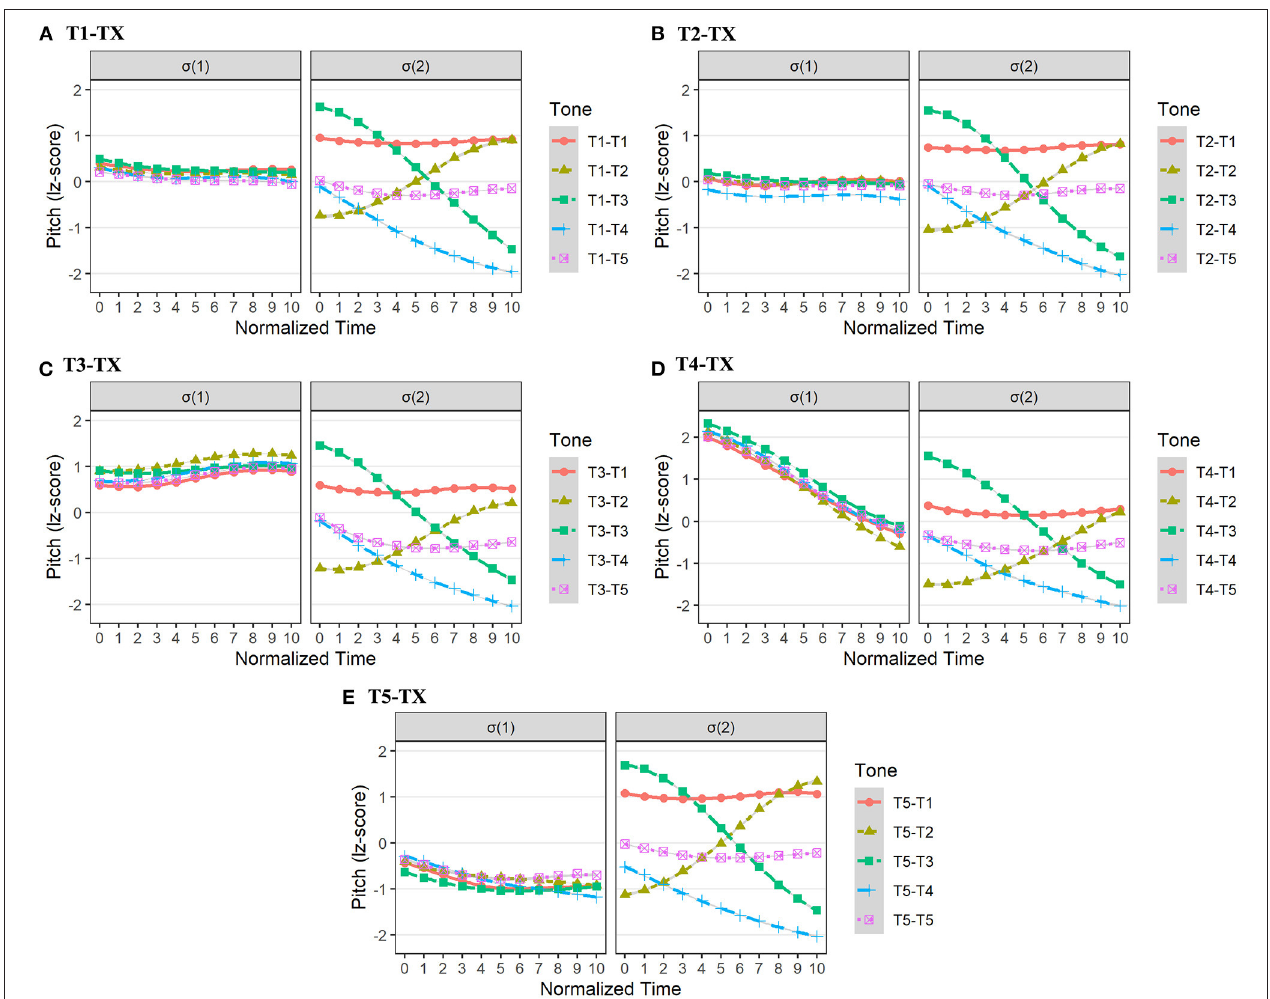
FIGURE 7 | The pitch realizations of σ (1) and σ (2) in Xiamen dialect with tonal combinations of T1-TX (A) , T2-TX (B) , T3-TX (C) , T4-TX (D) , and T5-TX (E) .